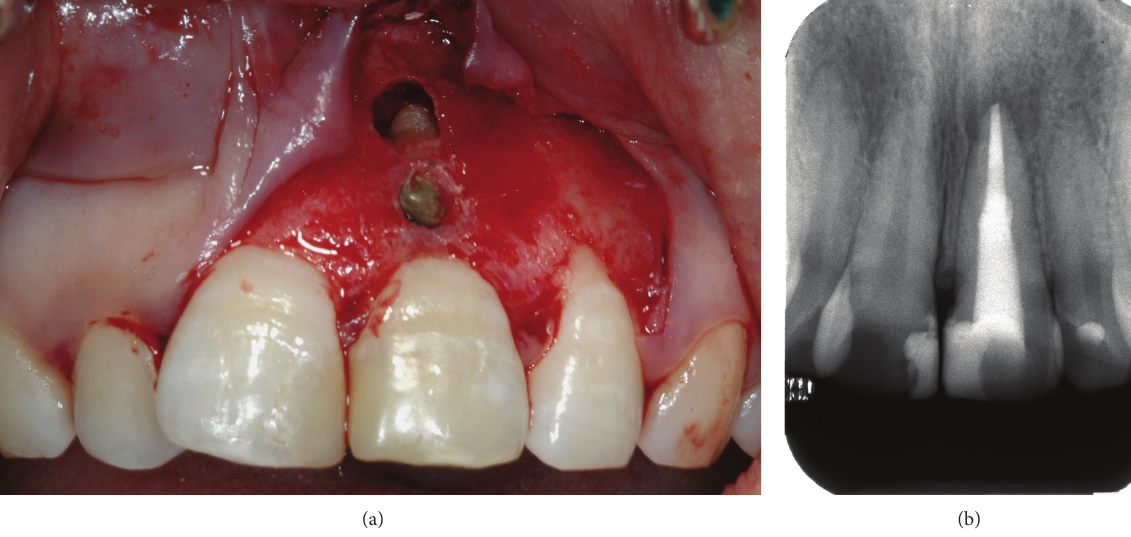
Figure 7: (a) Curettage of the lesions after raising the split thickness flat. (b) Radiograph taken during the